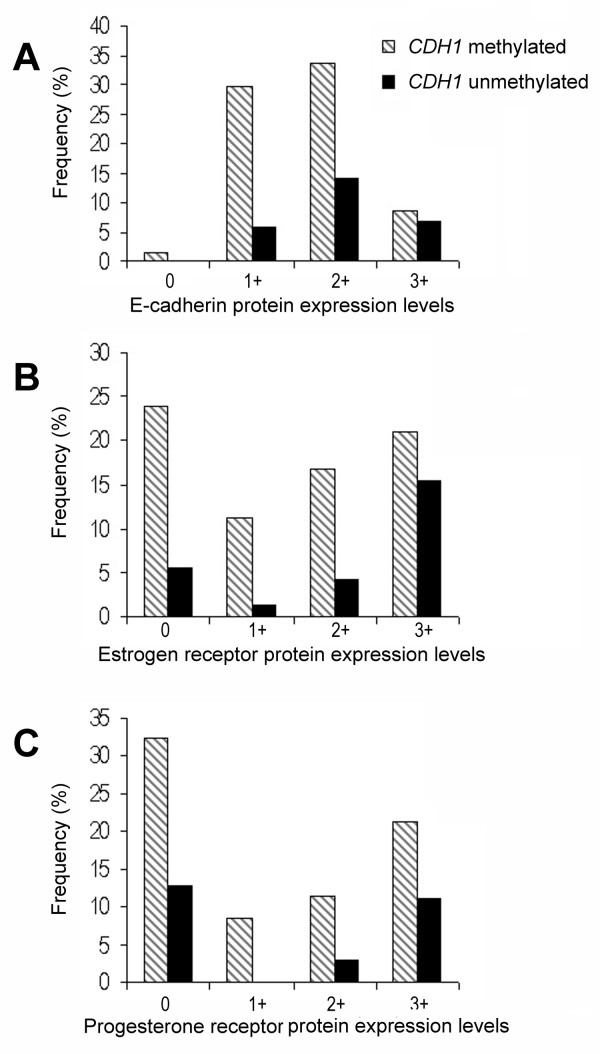
Frequency distribution of the CDH1 methylation pattern in 71 infiltrating ductal carcinomas, categorized by the protein expression levels of A) E-cadherin, B) ER and, C) PgR, respectively.